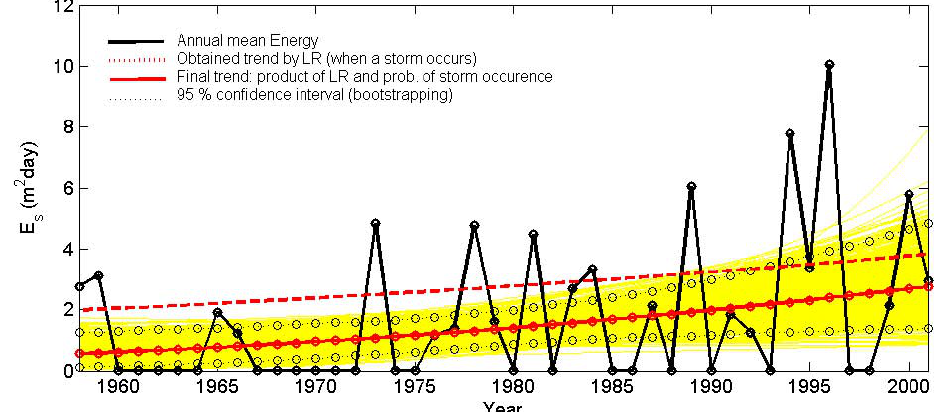
Fig. 9. An example of trend quantification of annual mean E s from S (node 2, see Fig. 1). LR means linear